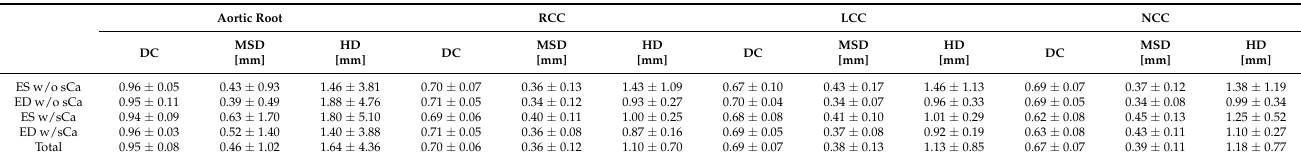
Table 2. Segmentation Results by Dice Coefficient, Mean symmetric Surface Distance and Haus- dorff Distance.